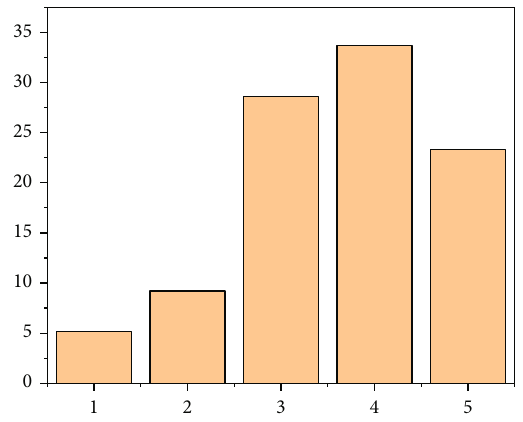
Figure 6: Distribution of problem scoring results.